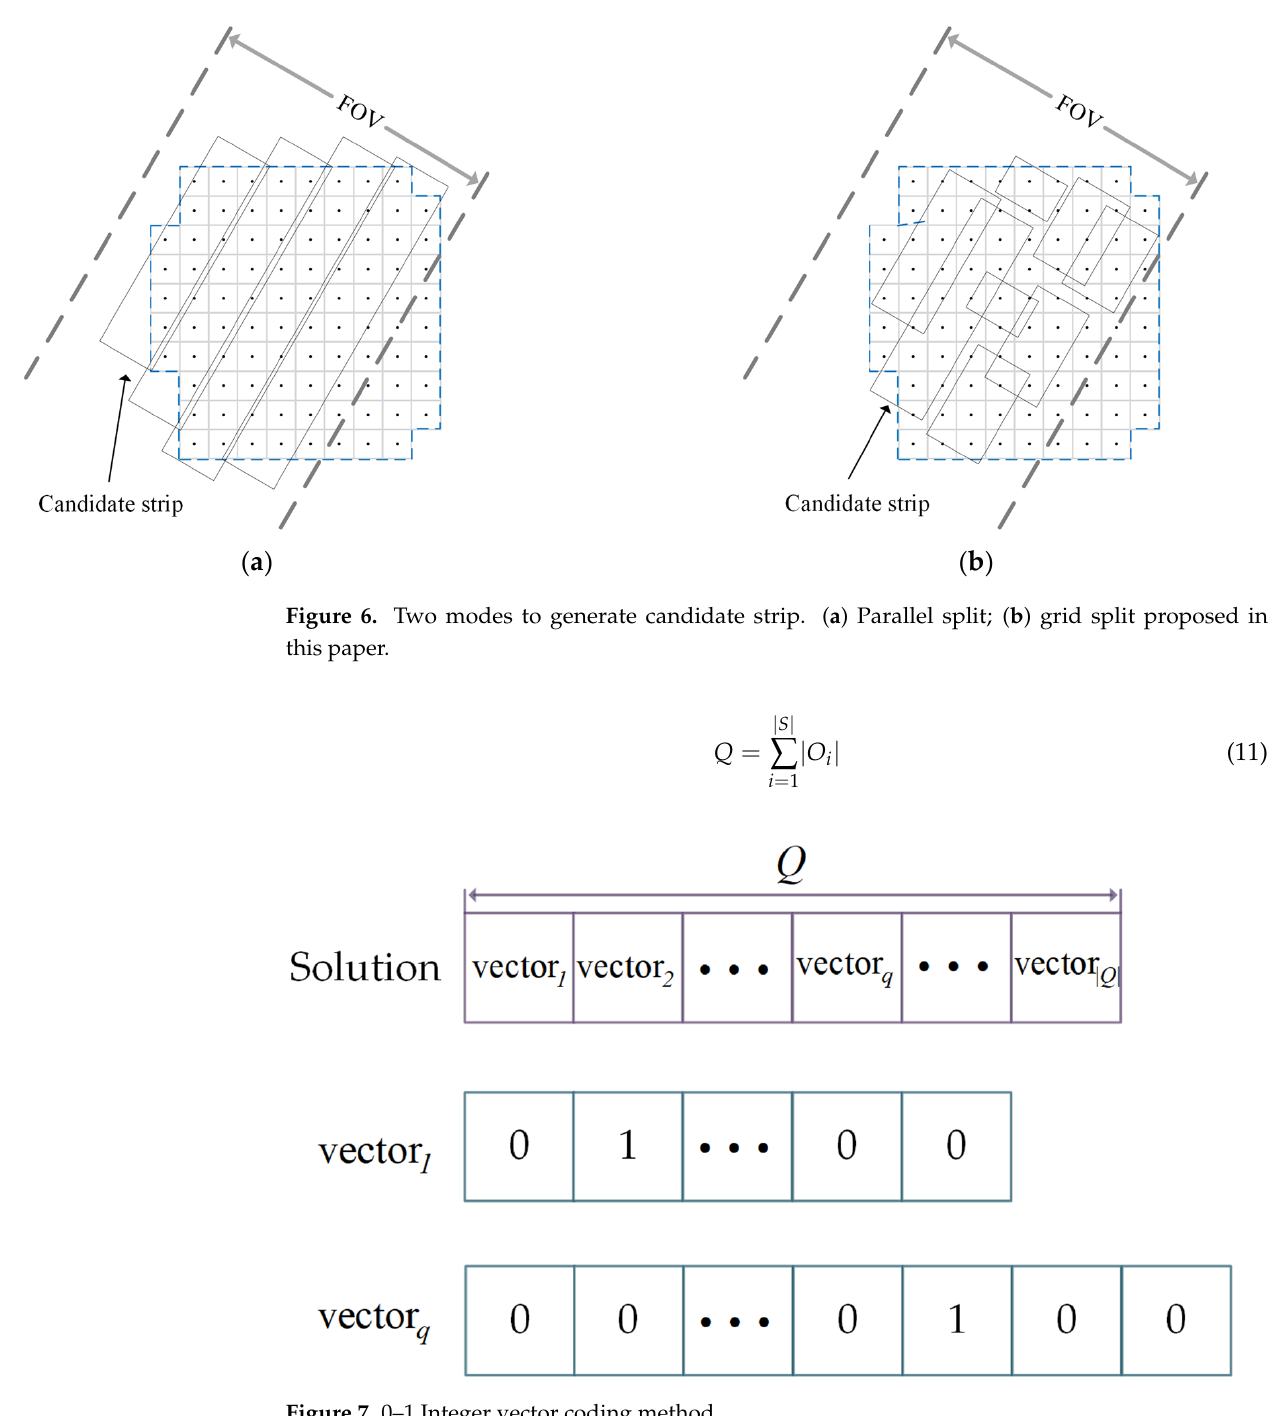
Figure 7. 0–1 Integer vector coding method.